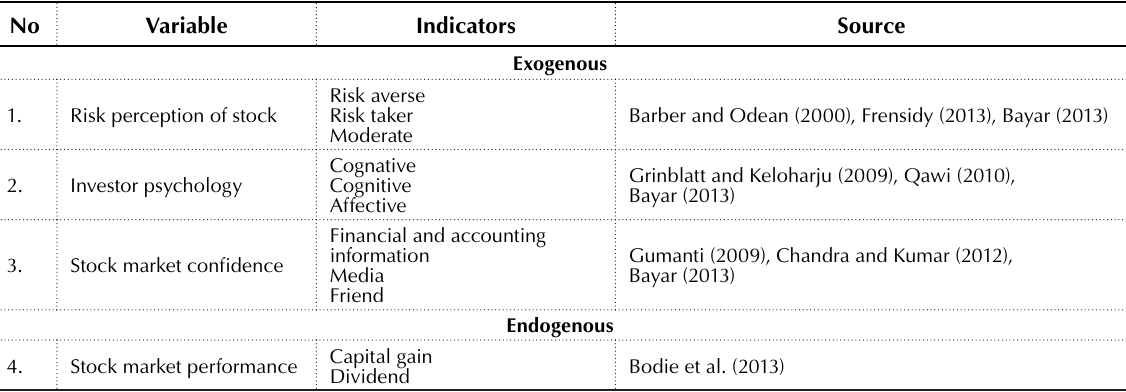
Table 2. Operational variable